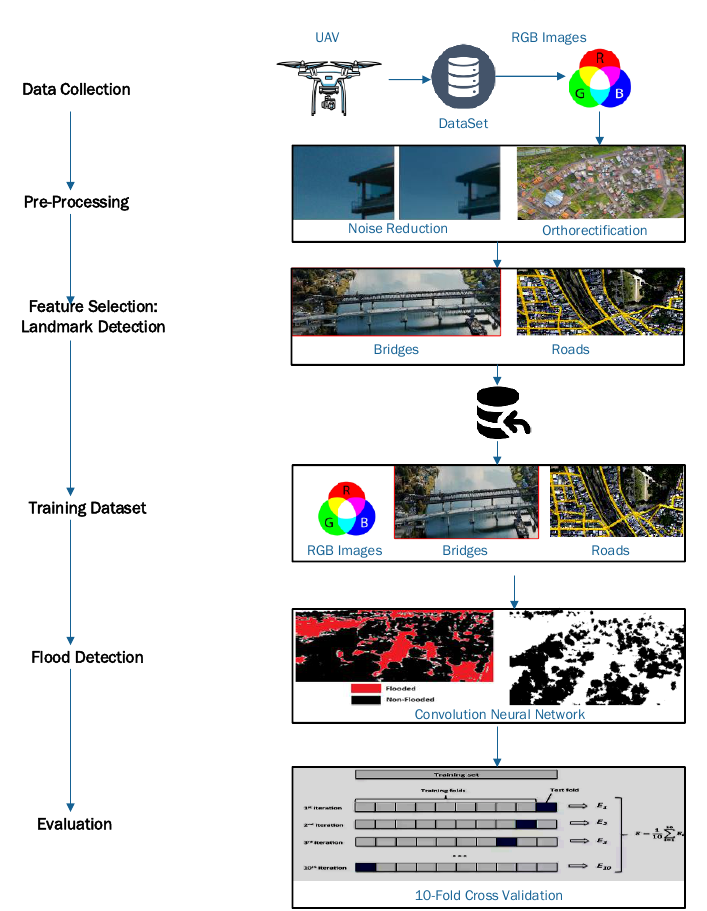
Figure 3. Proposed methodology.